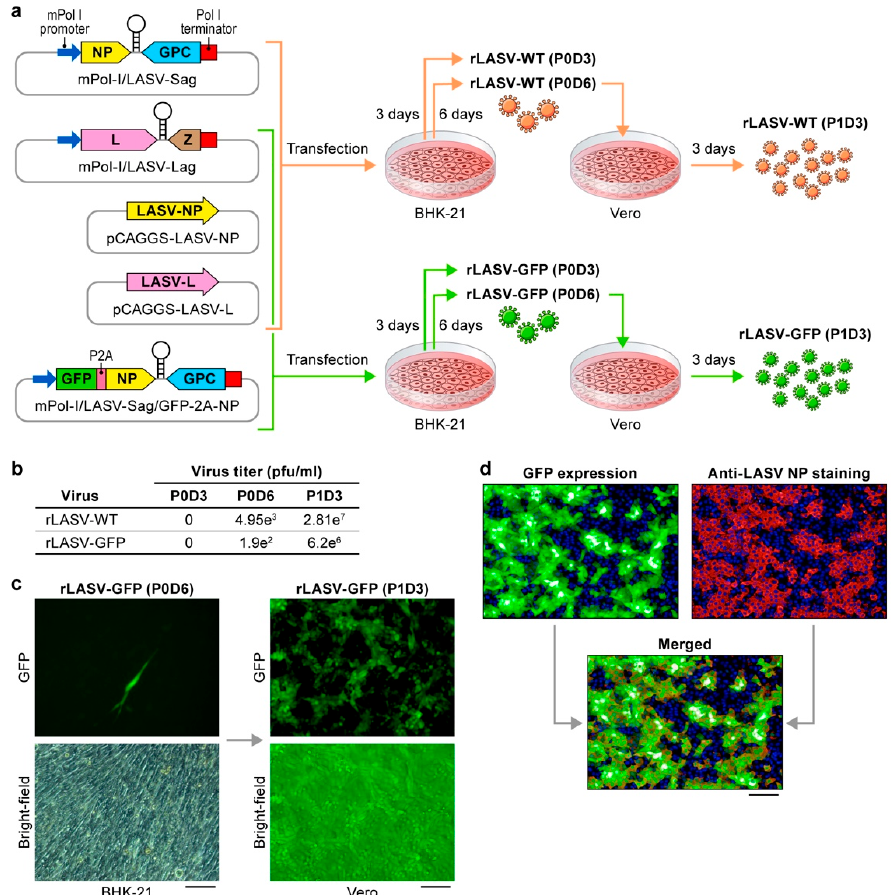
Figure 1. Rescue of recombinant LASV expressing GFP (rLASV-GFP). ( a ) Rescue strategy. Support plasmids pCAGGS-LASV-NP and pCAGGS-LASV-L express LASV nucleoprotein (NP) and viral RNA-